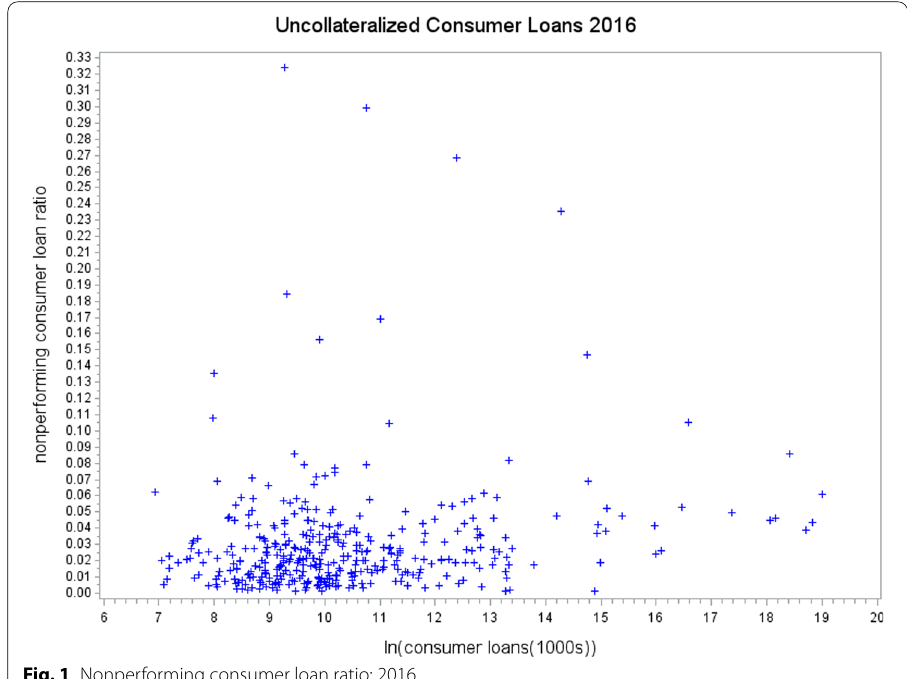
Fig. 1 Nonperforming consumer loan ratio: